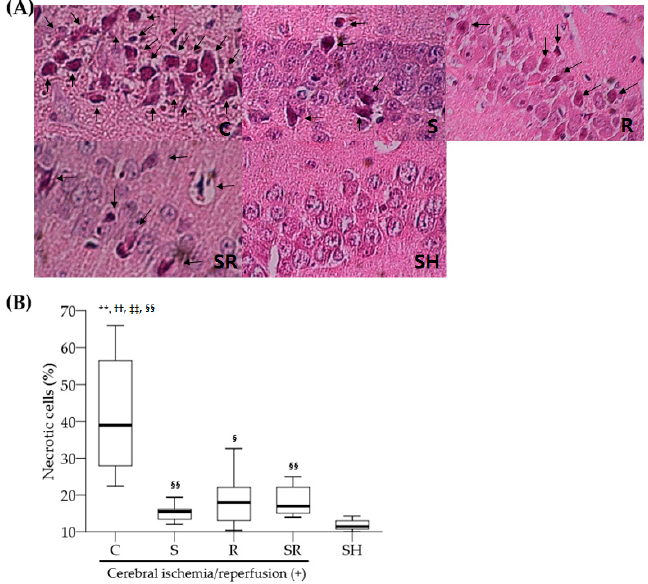
Figure 1. ( A ) Representative photomicrographs (×800) from a single rat with H&E staining in the hippocampal CA1 regions one day after transient global cerebral ischemia. Necrotic neurons (arrows) show karyolytic or pyknotic nuclei and cytoplasmic shrinkage; ( B ) The percentage of necrotic cells. Box plot indicates median, inter-quartile, and full ranges. C: control; S: sevoflurane postconditioning; R: resatorvid; SR: sevoflurane postconditioning + resatorvid; SH: sham. ** p < 0.01 for Group S; †† p < 0.01 for Group R; ‡‡ p < 0.01 for Group SR; §§ p < 0.01 for Group SH; § p < 0.05 for Group SH.